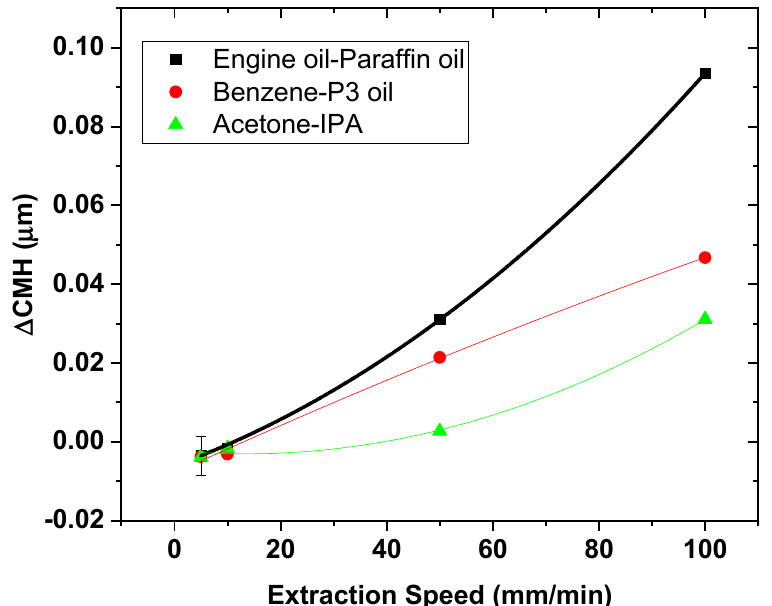
Figure 8. Depiction of the CMH variation as the dynamic viscosity of the liquid changes.